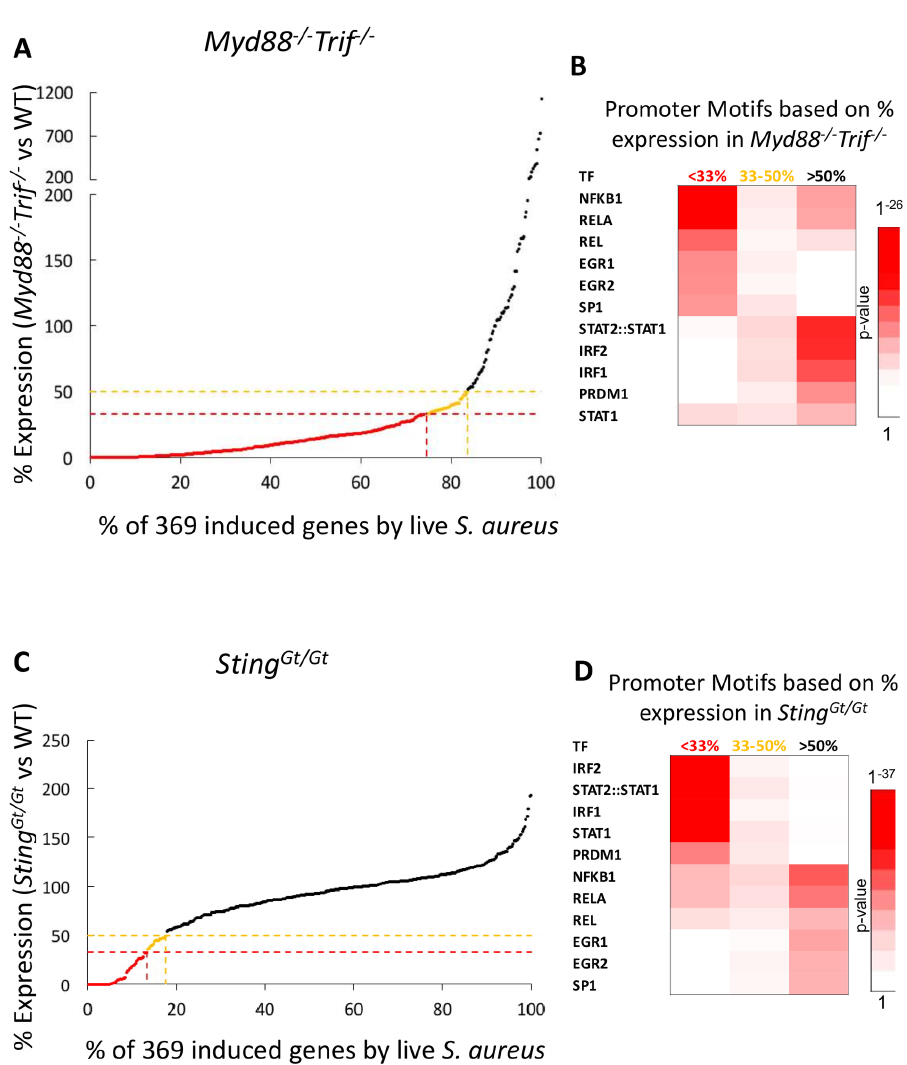
Fig 2. Toll-like receptor and STING signaling dominate the transcriptional response to S . aureus in murine macrophages. (A) RNA-Seqof Myd88/Trif -/- macrophages was compared to that of WT macrophages. Shown is the % expressionvalue of the 369 genes inducedby live S . aureus in Myd88/Trif -/- macrophages compared to WT macrophages. The averageexpressionfrom two separateexperiments of WT and Myd88/Trif -/- macrophages treated at the same time with the same dose of S . aureus at 5 different time points in each experiment is shown. (B) Known, highly significantJaspar 2016 motif enrichment of genes separated by their degreeof dependence on Myd88/Trif -/- following S . aureus infection. (C) RNA-Seqof Sting Gt/Gt macrophages was comparedto that of WT macrophages. Shownis the % expressionvalue of the 369 genesinducedby live S . aureus in Sting Gt/Gt macrophages comparedto WT macrophages. The average expressionfrom two separateexperiments of WT and Sting Gt/Gt macrophages treated at the same time with the same dose of S . aureus at 5 different time points in each experiment is shown. (D) Known, highly significantJaspar 2016 motif enrichment of genes separated by their degreeof dependence on STING following S . aureus